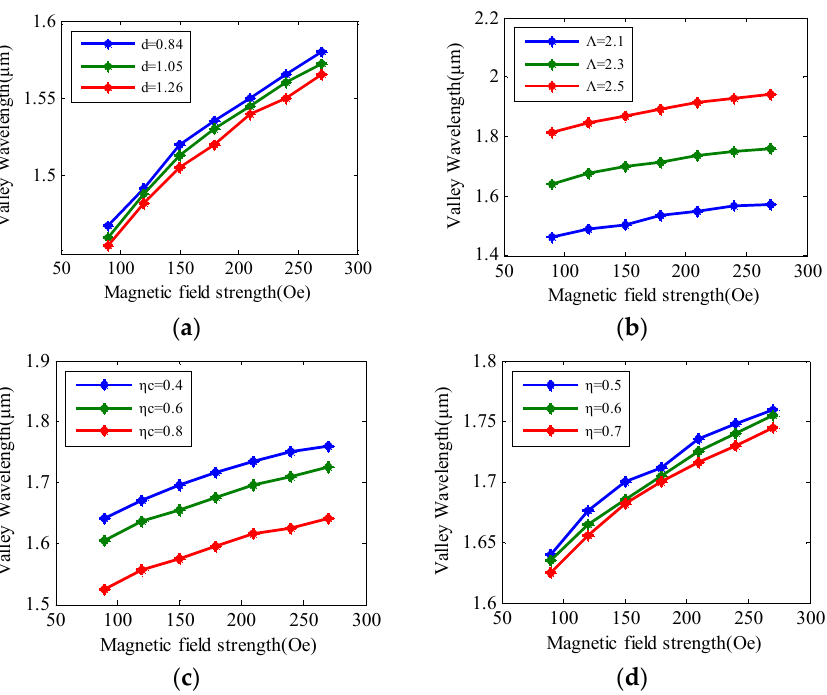
Figure 9. The valley wavelength of the optical power with different magnetic field strength. ( a ) The valley wavelength for different d. ( b ) The valley wavelength for different Λ . ( c ) The valley wavelength for different η c. ( d ) The valley wavelength for different η .